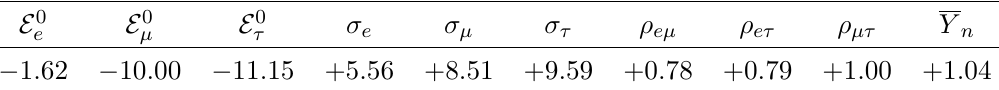
Table 3 . Fitted values of the parameters of the approximate ∆ χ 2